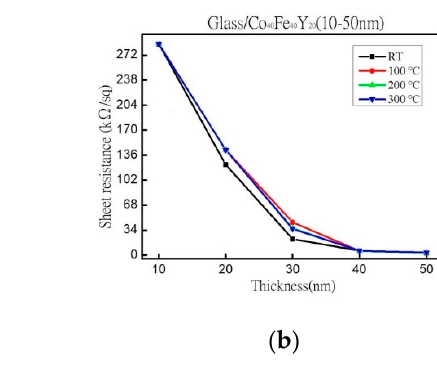
Figure 7. ( a ) The resistivity. ( b ) The sheet resistance.